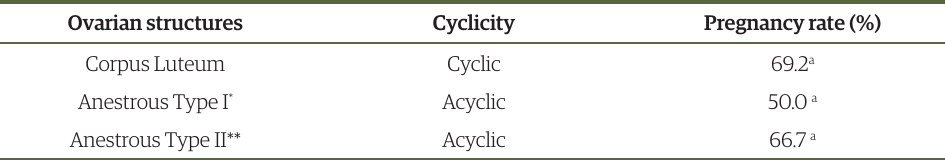
Table 3. Effect of stratification of the ovarian condition on the pregnancy rate of Girolando heifers submitted to Timed Artificial